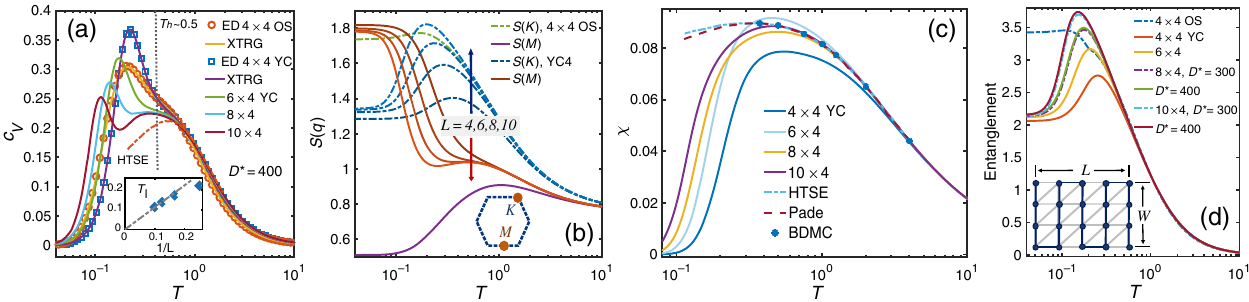
FIG. 8. Thermodynamics of the triangular lattice Heisenberg model defined on two W ¼ 4 geometries, OS with OBCs on both directions and Y cylinder (YC) with various lengths L , i.e., PBCs along the vertical direction [see the inset in (d) for our specific choice of the YC geometry, as well as the TLH lattice layout in Fig. 9(f) below]. The presented quantities include (a) specific heat c V , (b) static structure factor S ð q Þ at q ¼ K and q ¼ M at the boundary of the first Brillouin zone (see the inset), (c) uniform magnetic susceptibility χ , and (d) thermal entanglement versus temperatures. The inset in (a) depicts the temperature T l of the peak in c V at a lower temperature versus inverse length 1 =L , with the dashed line a guide for the eye. Note that the high-temperature scale in c V stays at T h ∼ 0 . 5 . The HTSE and Pad´e data is taken from Refs. [58,59] and BDMC from Ref. Fig. 8, we present exemplary XTRG results of TLH on width W ¼ 4 systems [see the inset in Fig. 8(d)], including